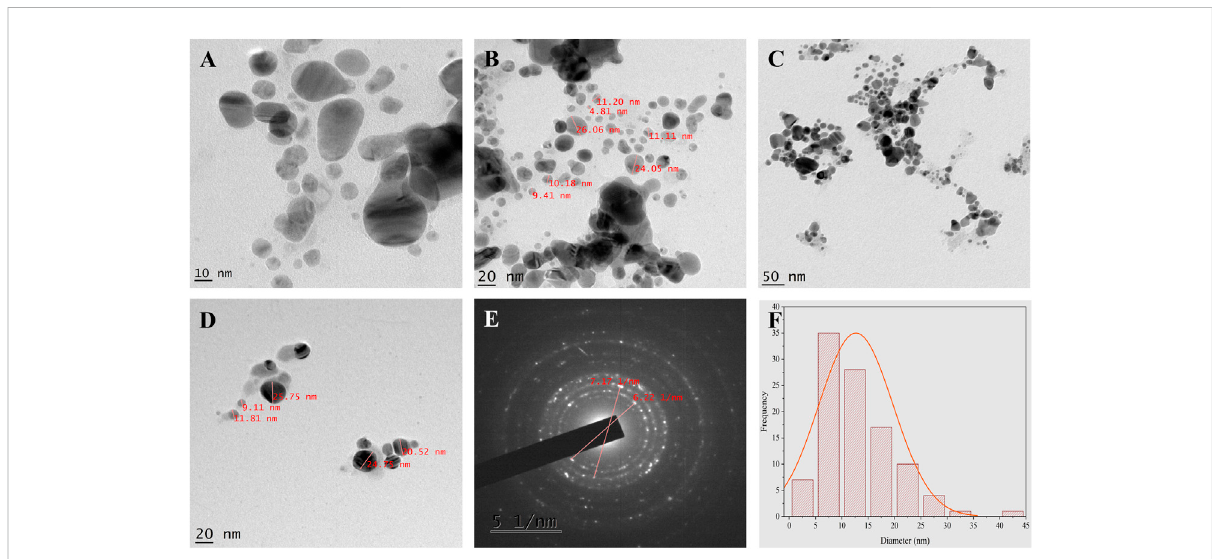
FIGURE 7 TEManalysis (A – D) TEMmicrographsofAgNPsatdifferentmagni fi cation (E) SAEDpattern (F) Histogramshowsaverageparticlesizedistribution of Synthesized